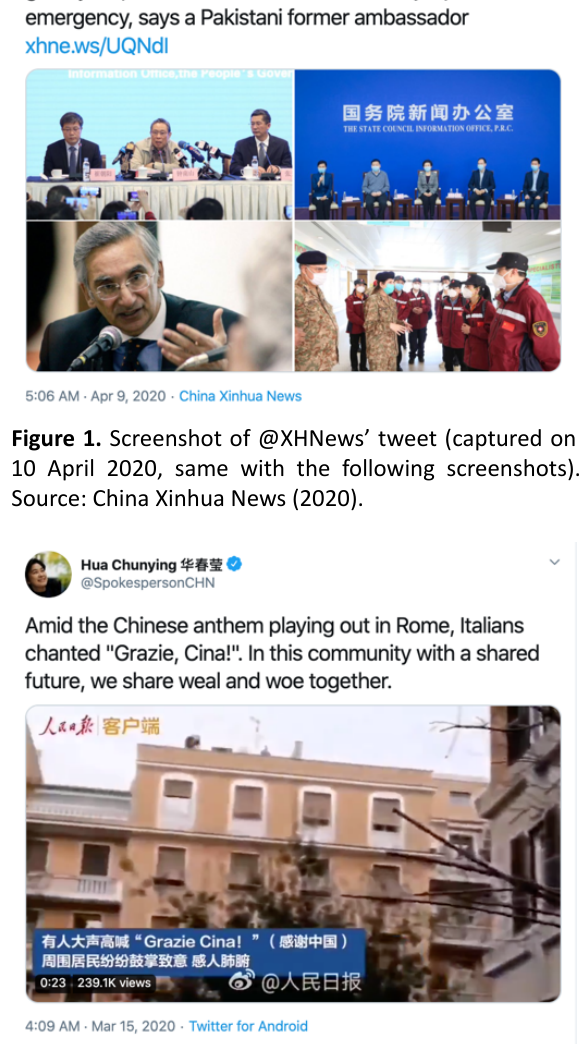
Figure 2. Screenshot of @SpokespersonCHN’s tweet. Source: Hua